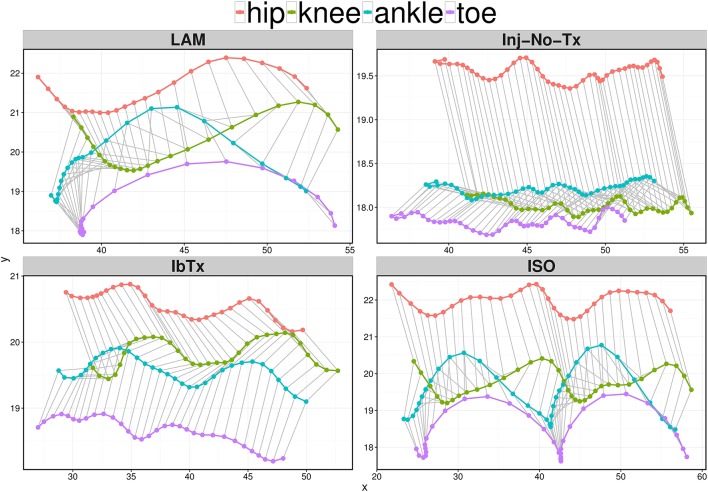
Representative stick figures of angles between the 4 kinematic joints depicting one (LAM) or two (Inj-No-Tx, IbTx, and ISO treated) step cycles. Stick figures of angles between the hip (red), knee (green), ankle (blue), and toe (purple) are depicted of one representative from each treatment group. ISO treated animals demonstrated two clear step cycles, similar to the one step cycle demonstrated from the LAM group. The Inj-No-Tx and IbTx treated representative shows no clear swing phase in the step cycle.